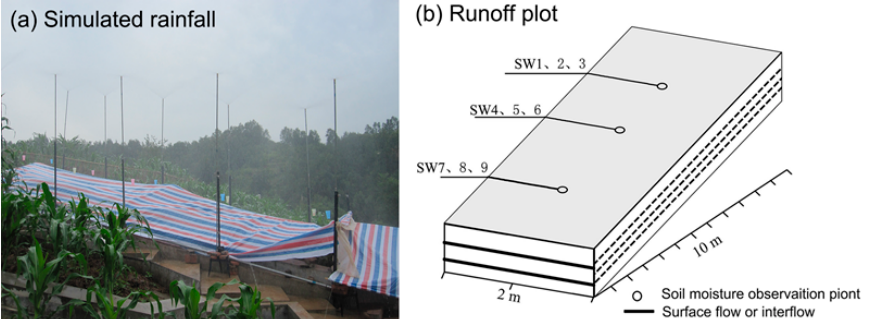
Figure 3. Some typical slope treatments.